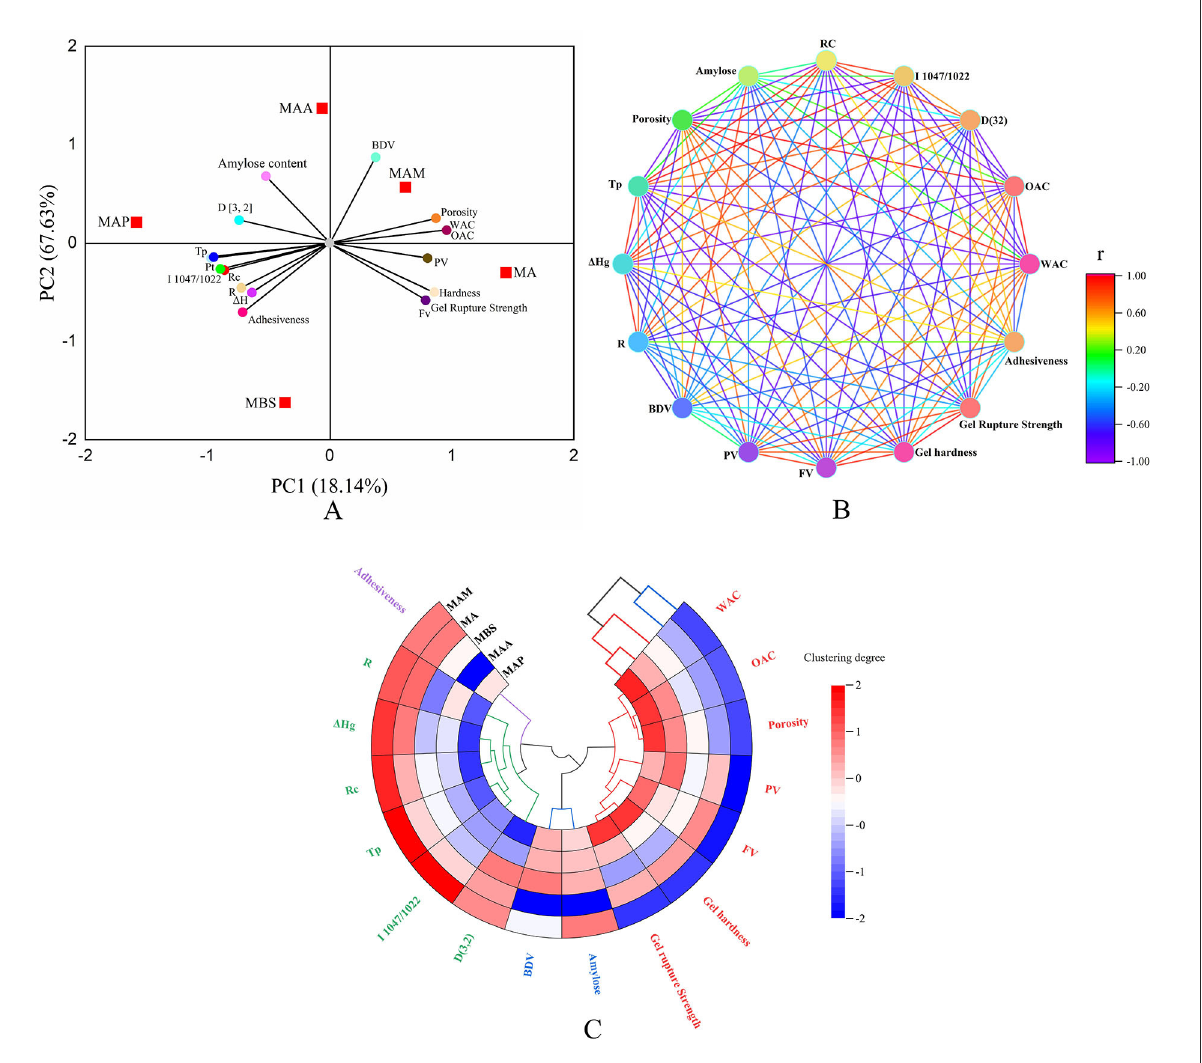
FIGURE4 Statistical analysis. (A) Principal component analysis (PCA) score and loading plot of PC1 and PC2 of starch samples. (B) Neural network analysis based on the Pearson method. (C) Cluster tree